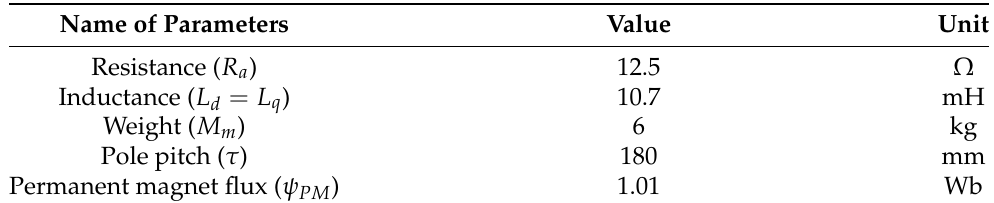
Table 1. Parameters of the linear motor.